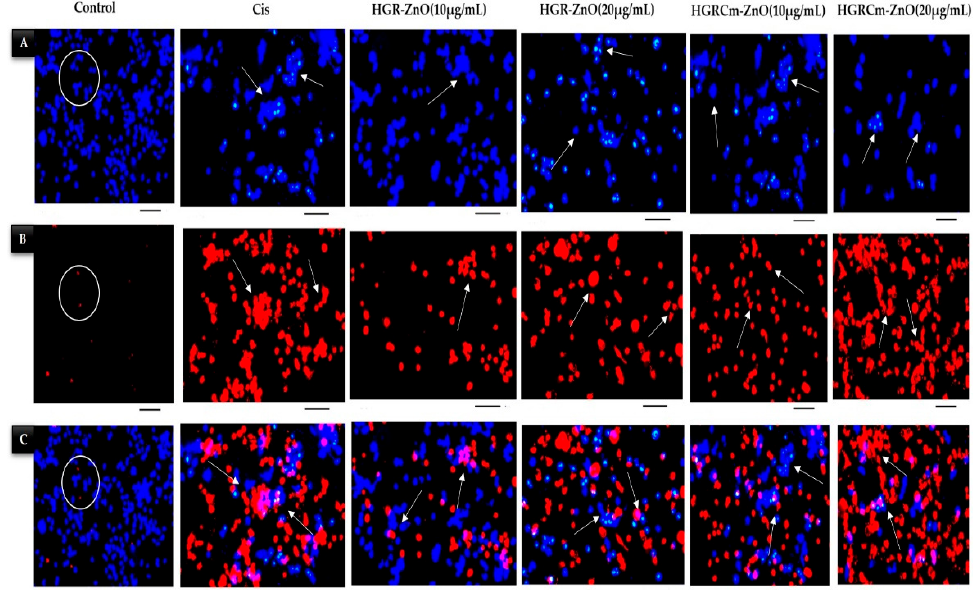
Figure 7. Hoechst and PI staining of HGRCm-ZnO NPs and detection of cellular apoptosis via cell disruption and breakage of the cell wall, as indicated with arrowheads. ( A ) Hoechst staining (light-blue live cells and dark-blue apoptotic cells), ( B ) PI staining (dark-red dead cells), and ( C ) merged images. Original scale bar 20 ×